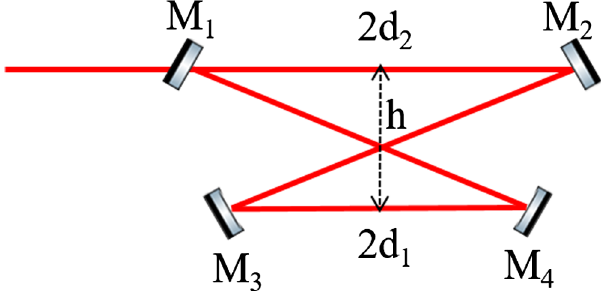
FIG. 4. Schematic view of a symmetric four-mirror planar cavity. M 1 , M 2 (M 3 , M 4 ) are planar (spherical) mirrors. Distances d d 1 , 2 and h describing the geometry are also shown. Mirror positions are symmetric with respect to the central vertical axis.